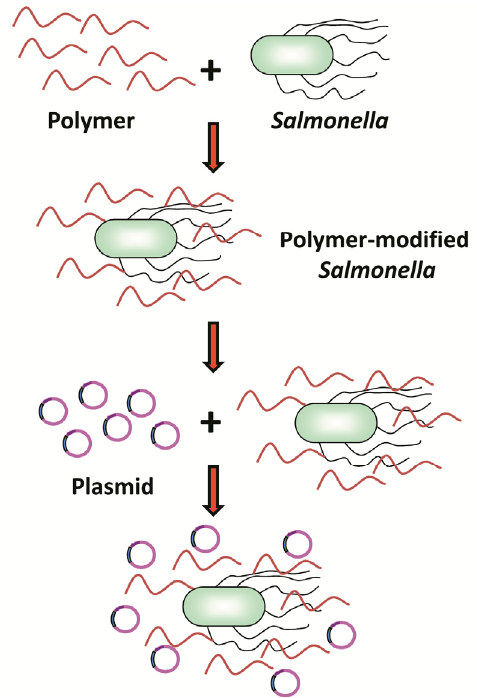
Figure 1. Schematic illustration of the strategy for the preparation of DNA-poly(allylamine hydrochloride) (PAH)- Salmonella.